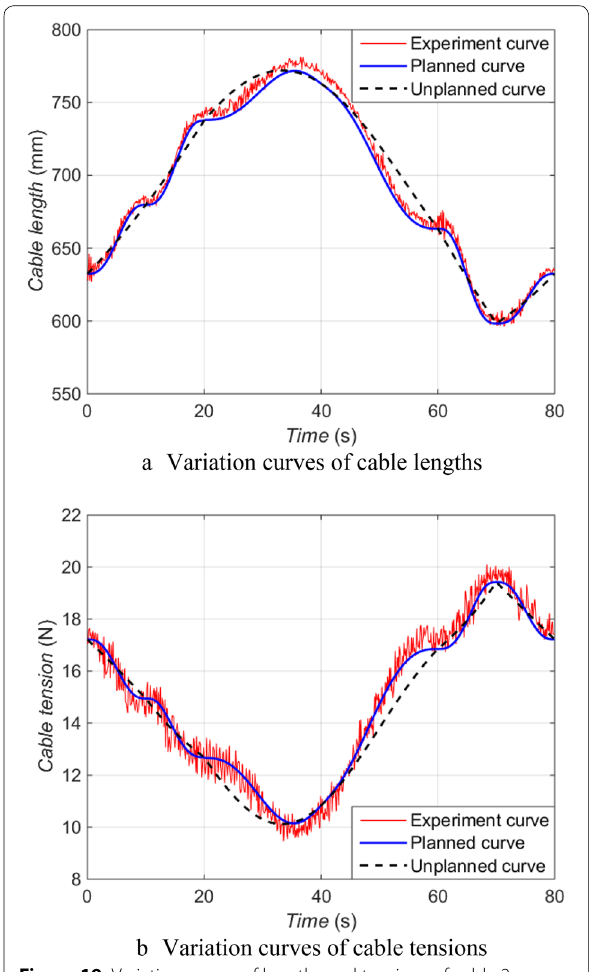
Figure 18 Variation curves of lengths and tensions of cable 1 Figure 19 Variation curves of lengths and tensions of cable